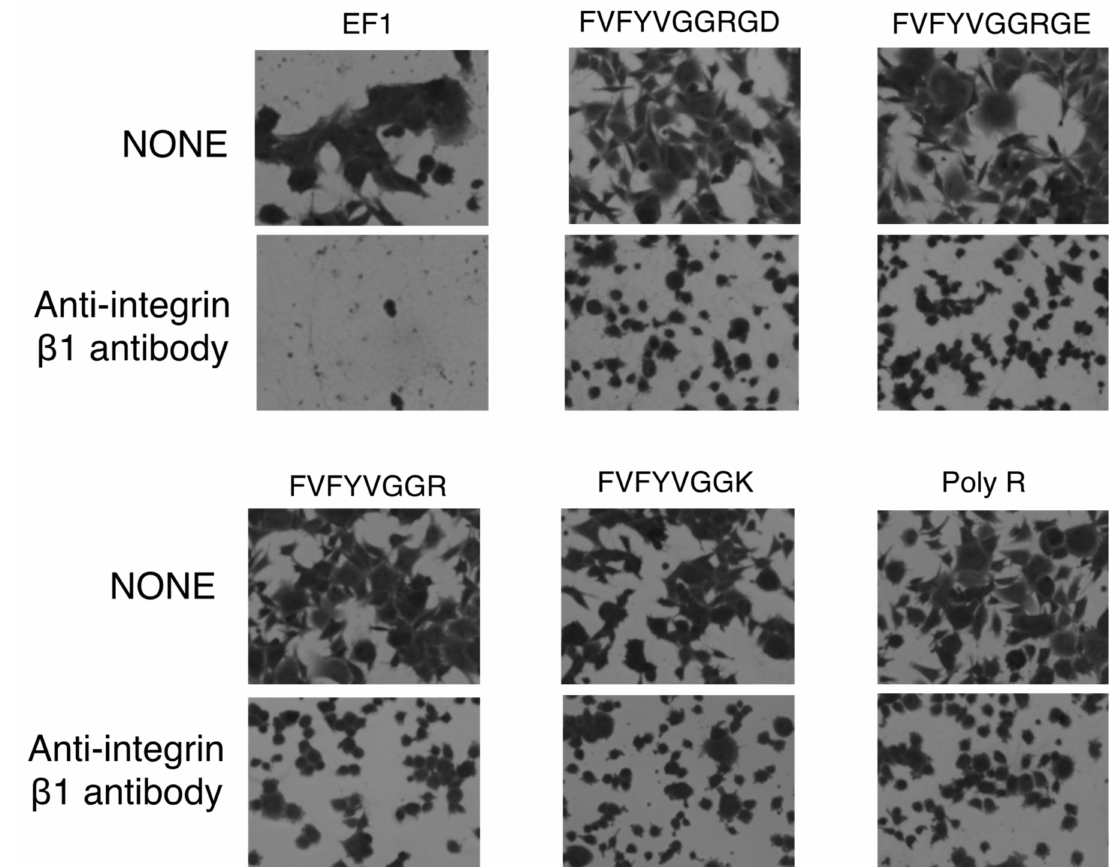
Figure 8. Effect of anti-integrin β 1 antibody on cell adhesion to peptides. HDFs were preincubated with 10 µ g/mL of integrin β 1 antibody at room temperature for 15 min and added to the peptide- coated plates (2 nmol/well of EF1, 5 nmol/well of FVFYVGGRGD and FVFYVGGRGE, 10 nmol/well of FVFYVGGR and FVFYVGGK, 1 ng/well of poly R). After incubation for 1 h, cells were stained with 0.2% crystal violet in 20%